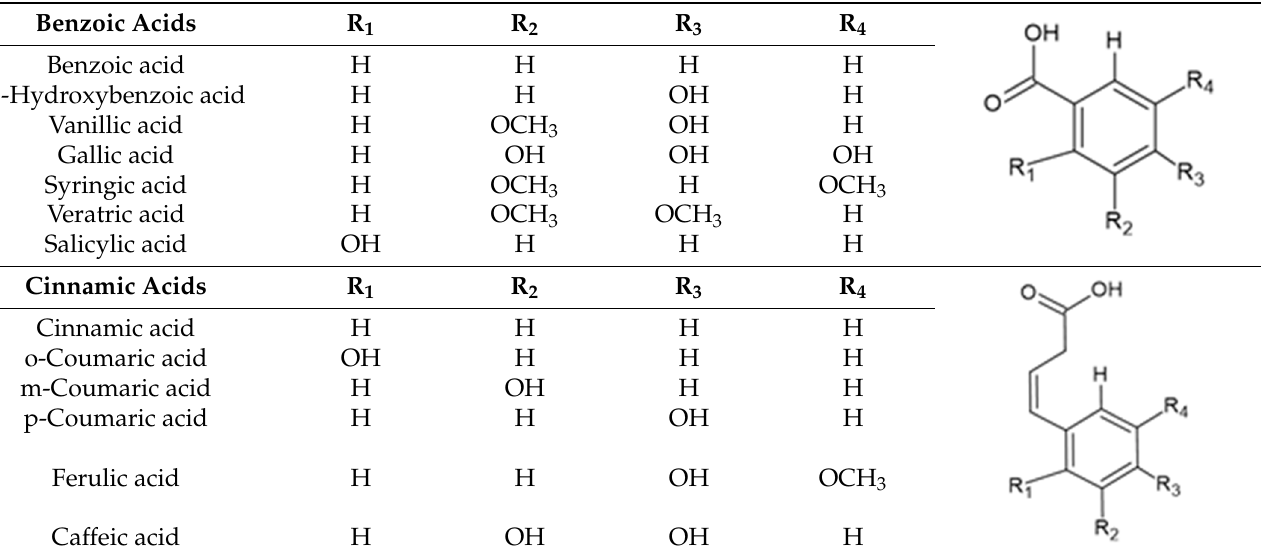
Table 1. Chemical structures of phenolic acids.